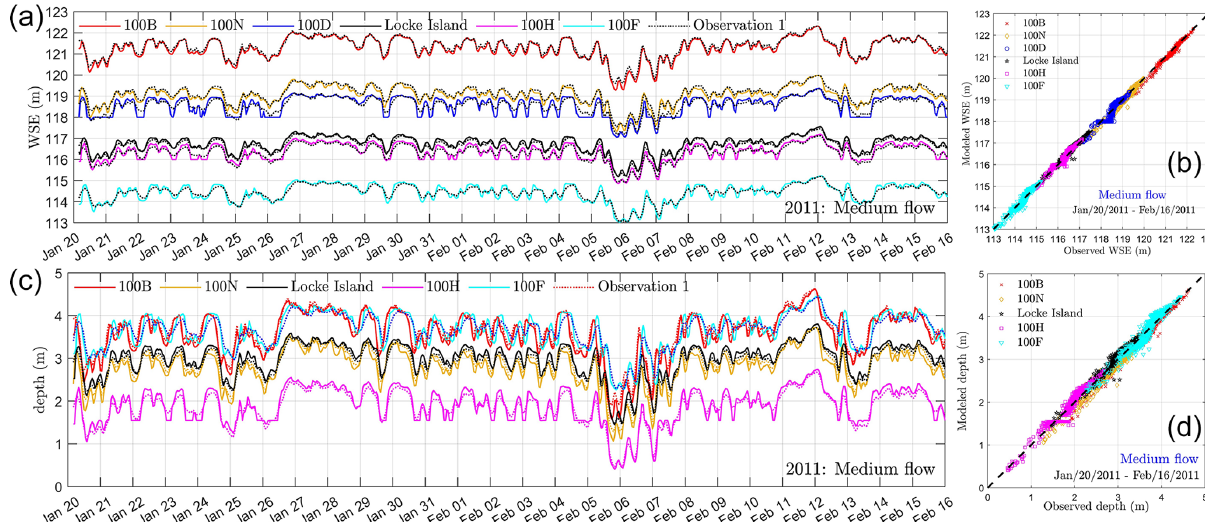
Figure 5. The comparisons of water surface elevation and depth between the model and observations using the calibrated roughness field (case OF in Table 1) during a medium flow in 2011. Panels (a) and (c) represent the hourly recorded WSE and depth, respectively. Panels (b) and (d) denote their 1 : 1